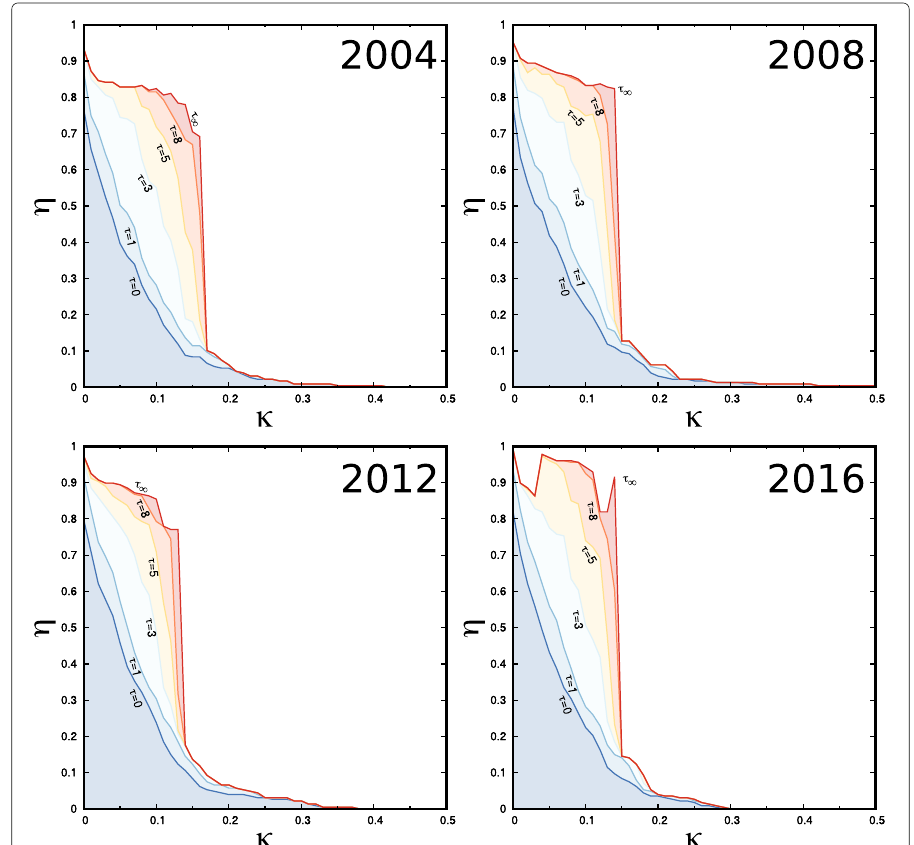
Fig. 3 Fraction of bankrupted countries for the WTN of 2004, 2008, 2012, and 2016. Fraction η of countries went to bankruptcy up to the τ th stage of crisis contagion as a function of the bankruptcy threshold κ . The crisis contagion has been computed for the WTN of 2004 (top left), 2008 (top right), 2012 (bottom left), and 2016 (bottom right). Once a country goes to bankruptcy, it is prevented to import products with the exception of petroleum and gas (model A). The damping factor is α =